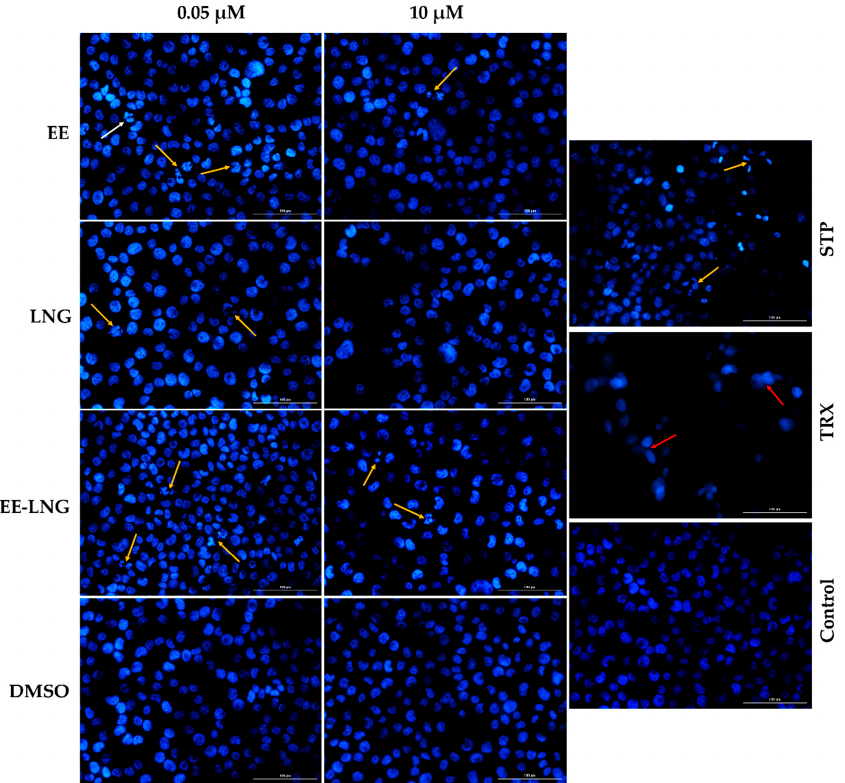
Figure 3. Cell nuclei staining using Hoechst 33342 in MDA-MB-231 cells after the treatment with EE, LNG, EE-LNG, and DMSO (0.05 and 10 µM) solutions for 24 h. The pictures were taken 24 h post-treatment. Staurosporine (STP) solution 5 µM was used as a positive control for apoptotic changes at the nuclear level and Triton X-100 (TRX) solution 0.5% was used as an indicator for necrosis. The yellow arrows indicate the apoptotic cells with nuclear fragmentation, the red arrows indicate necrotic nuclei, and the white arrow shows the nucleus of a cell undergoing mitosis. The scale bars represent 100 µm.